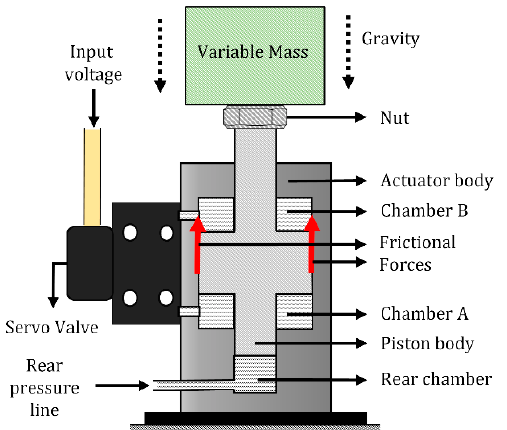
Figure 8. Schematic of the experimental setup to calibrate the static frictional force.